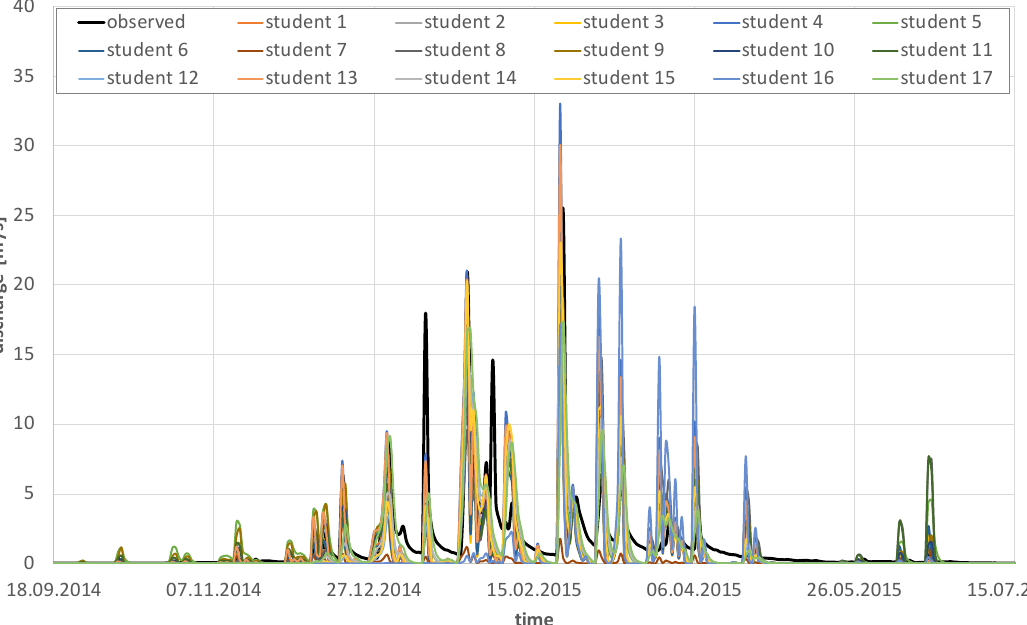
Figure 2. Variability of the discharges simulated by the different modellers against observations for an exemplary wet season (2014/2015) of the simulation period.